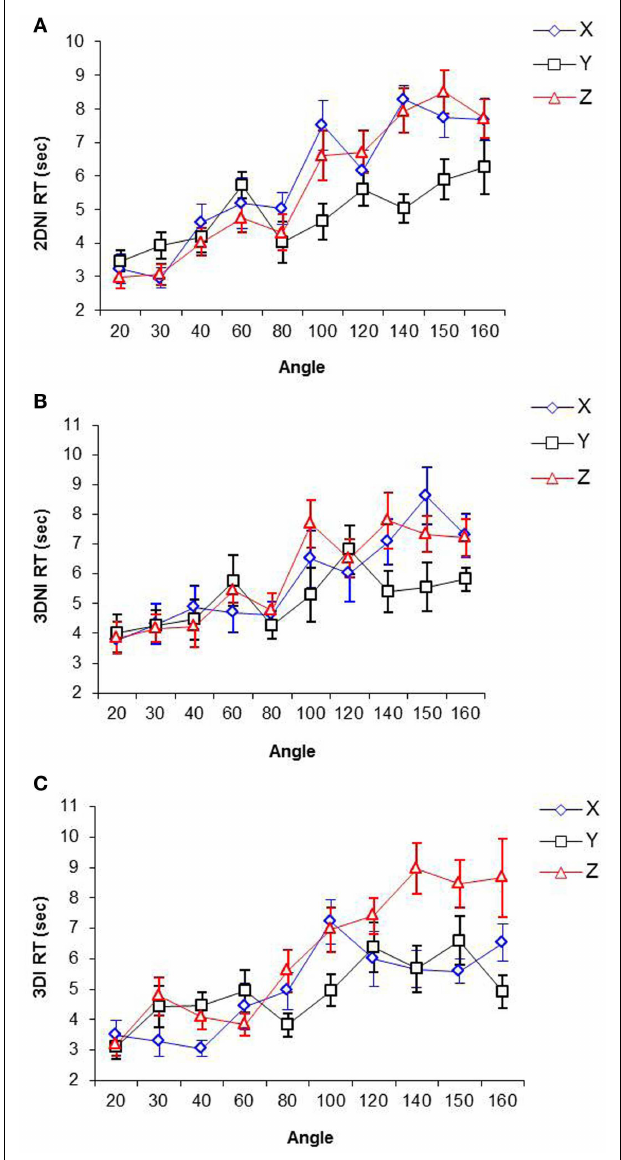
FIGURE 3 | Response time as a function of axis of rotation and viewing environment (2DNI, 3DNI, and 3DI). Error bars represent standard error means.